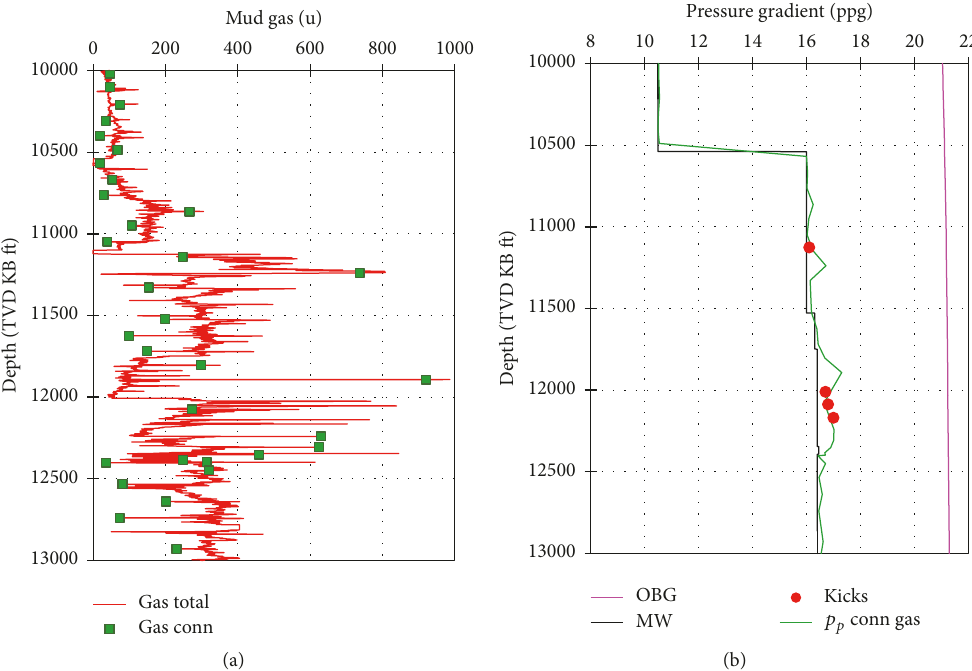
Figure 6: The pore pressure estimated from the connection gas using (12) in a shale gas well. (a) shows the total gas and connection gas (Gas conn); (b) presents the calculated pore pressures compared to the kicks, mud weight (MW), and overburden stress